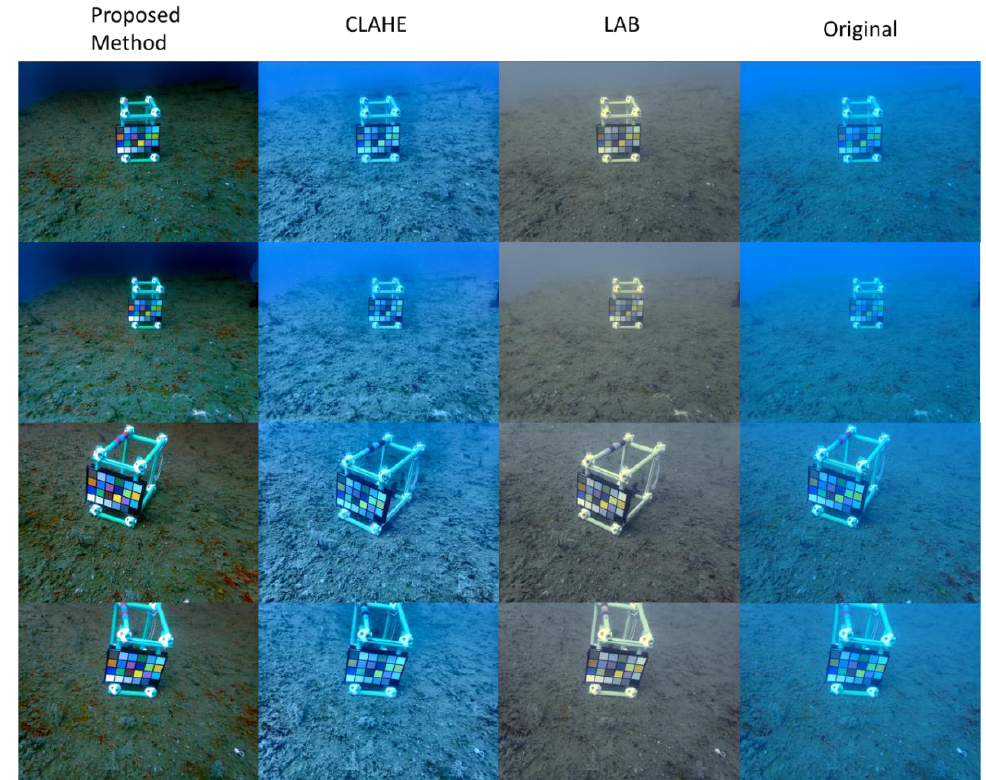
Figure 9: From Left to right the results provided by our algorithm, Lab, CLAHE, and the original images. Images from Limassol